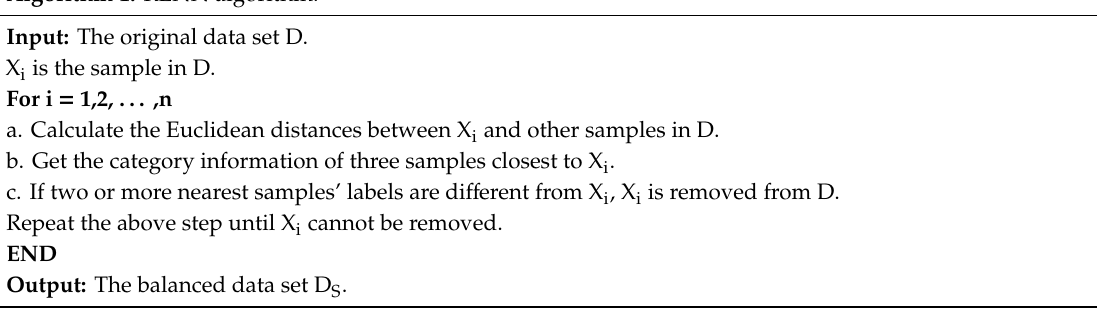
Algorithm 1. RENN